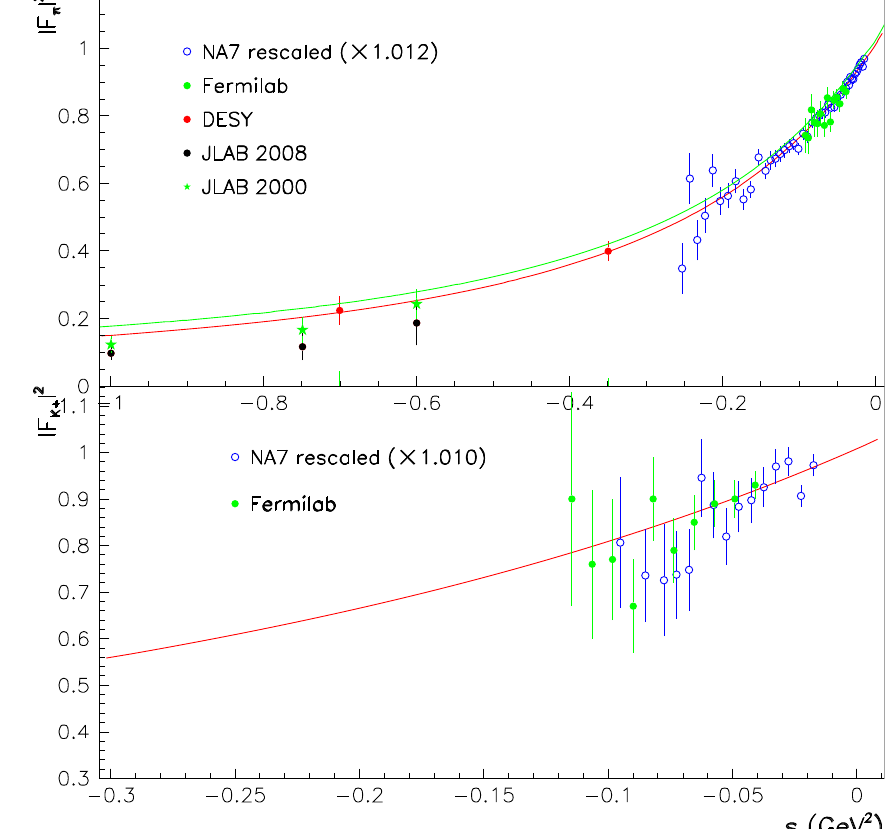
Fig. 6 Form factors squared in the spacelike region. The top panel displays the BHLS 2 prediction (green curve) and the fit (red curve) together with the rescaled data for | F π ( s ) | 2 . The bottom panel displays the fit and the rescaled data for | F K ± ( s ) | 2 ; the prediction from the fit excluding the spacelike data exactly superimposes to the fit (red curve). The unfitted points from DESY and JLab are only superimposed. See Sect. 18